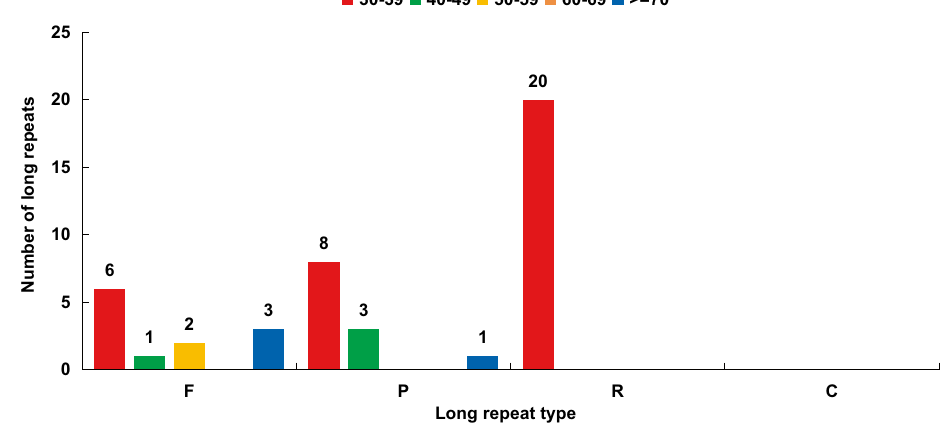
Figure 6. Distribution types and number of long repeats in chloroplast genomes of A. episcopale . REPuter was used to identify repeat sequences with length ≥ 30 bp and sequence identified ≥ 90%. F, P, R, and C indicate the repeat types F (forward), P (palindrome), R (reverse), and C (complement), respectively. Different colors indicate repeats with different lengths.